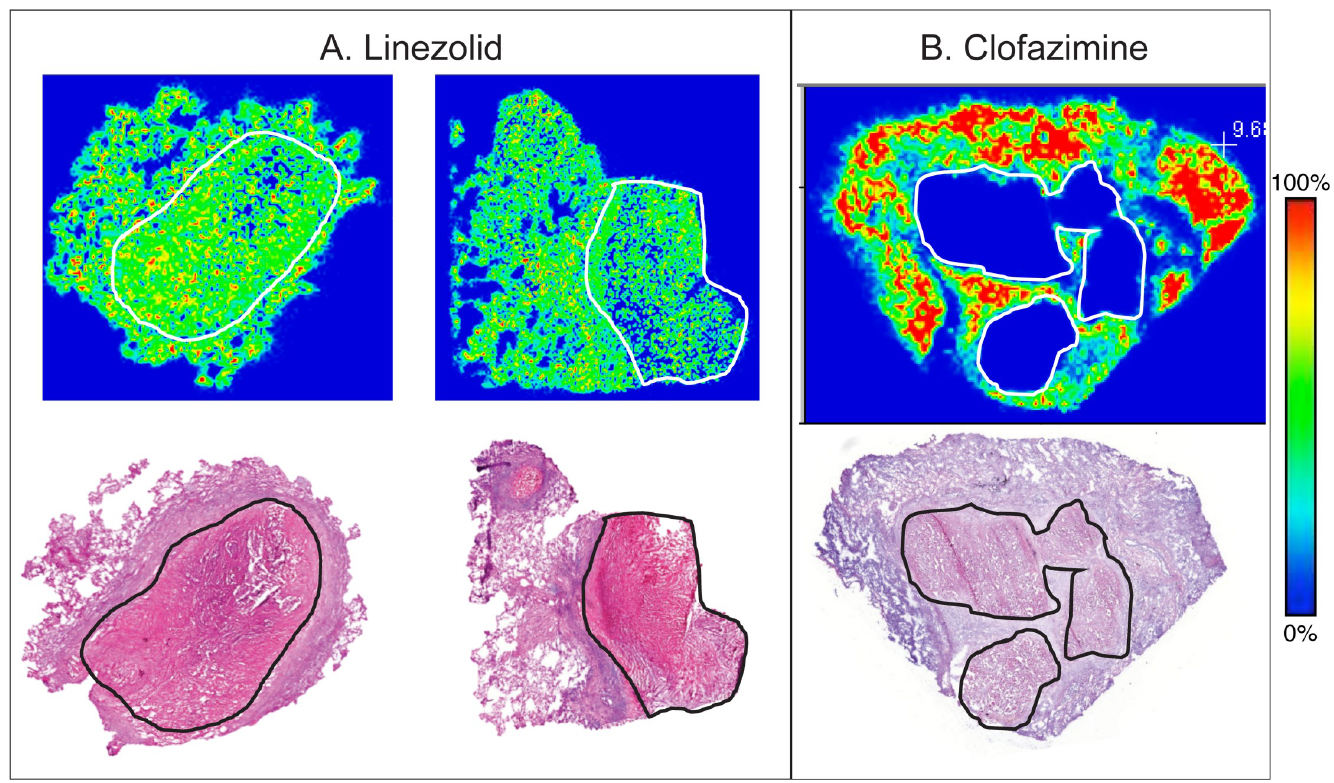
Fig 2. Two-dimensional imaging of LZD and CFZ by MALDI-MS. MALDI-MS ion maps of LZD and CFZ that provide a semiquantitative measure using the relative ion abundance of specific analytes in regions of interest. The highest signal intensity is fixed to 100% for each drug (red) and 0% indicating no detectable drug present (blue) on the rainbow color scale bar to the right. The caseum area is demarcated by the white line in the MALDI-MS image and corresponds to the black line of the histologically stained lesion images of the same sample in the bottom panel. A. The top panel of a nodule caseum and cavity lesion resected 20 h after LZD administration. LZD partitions favorably into cavity and nodule caseum in vivo, as indicated by the green color present in caseum and surrounding tissue showing similar concentrations in both. B. Clofazimine at steady state and 5 h post dose shows low penetration into the large necrotic granuloma in the top panel, as indicated by the blue area. CFZ, clofazimine; LZD, linezolid; MALDI-MS, matrix-assisted laser desorption-ionization mass